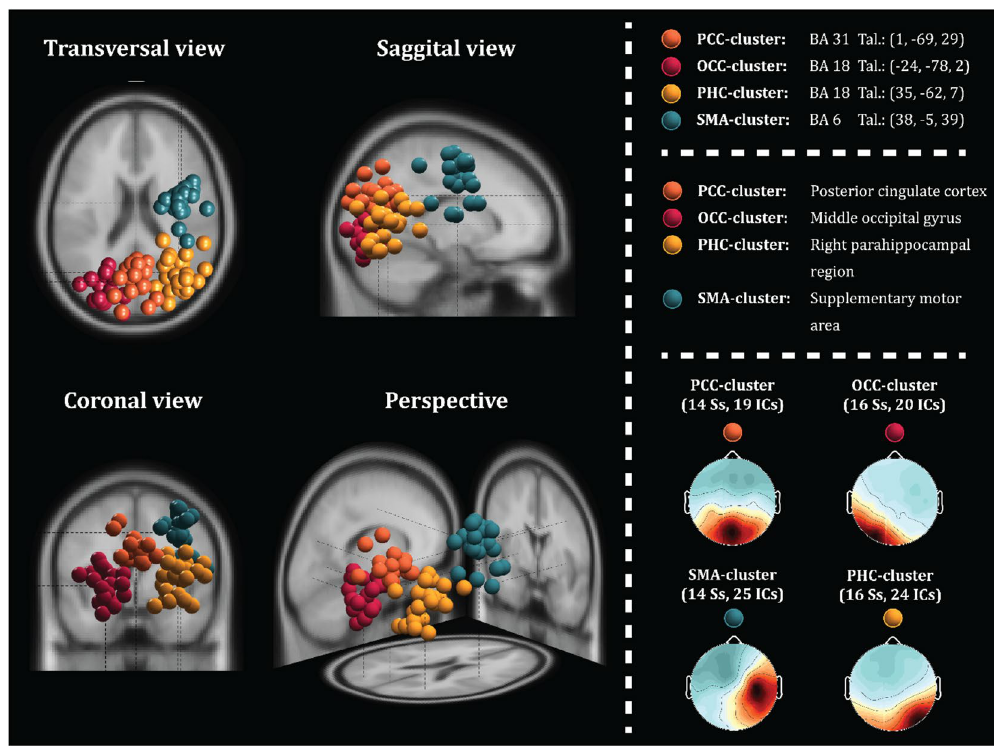
Figure 4. In the left panel, a plot of 3D dipole source locations of Cluster 3, 6, 9 and 11 are depicted onto the MNI model. The centroid of Cluster 3 corresponds to BA31, while Cluster 6 corresponds to BA18 towards the occipital lobe and Cluster 11 towards the parahippocampal region in BA18. The centroid of Cluster 9 corresponds to BA6. The lower right panel displays the averaged scalp maps with each its respective number of participants and